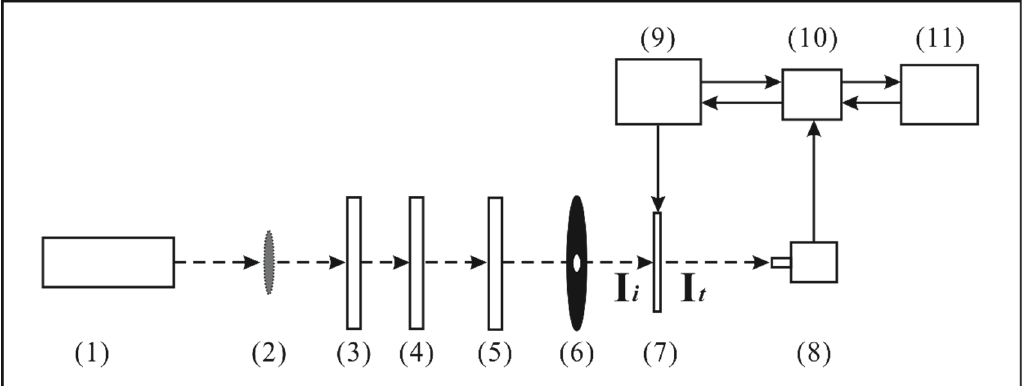
Figure 1. The schematic diagram of the electro-optical measurement. (1) He-Ne laser, (2) attenuator, (3) polarizer, (4) λ /4 wave plate, (5) polarizer, (6) diaphragm, (7) sample, (8) detector, (9) voltage amplifier.